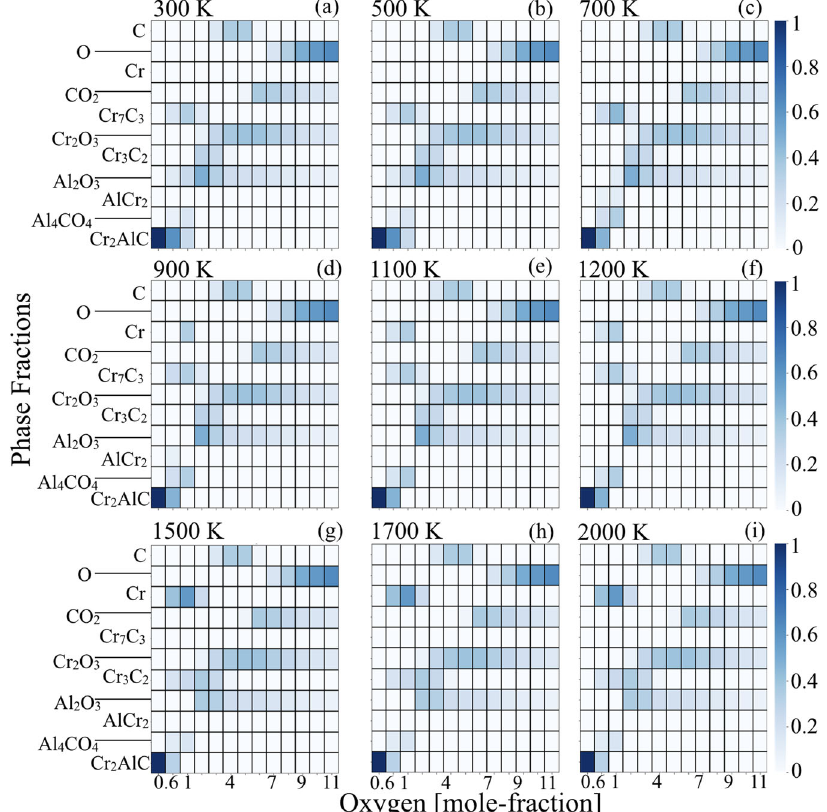
Fig. 9 Competing phases and phase-fraction of Cr 2 AlC + O 2 MAX phase. a – i Phase fractions of [Cr 2 AlC + O 2 ] reaction product at different temperature with changing molar percent oxygen. Each block refers to speci fi c oxygen molar content from 1 – 11 moles. The color gradient (shades of blue) shows molar phase fractions. Blank spot [white (0)] suggests no phases The predicted oxidation reaction chain for Cr 2 AlC at 1200 K is shown in Table 3 (also see Supplementary Table 8) The reaction table shows thermodynamically stable oxidation reaction products at varying oxygen mole fractions. The molar-oxygen content is varied to show its effect on reaction products, which represents the exposure time of the alloy to static air in experimental conditions. The reaction products of the chemical process during the selective oxidation of Al or Cr in Cr 2 AlC for low/intermediate oxygen exposure can be written as: